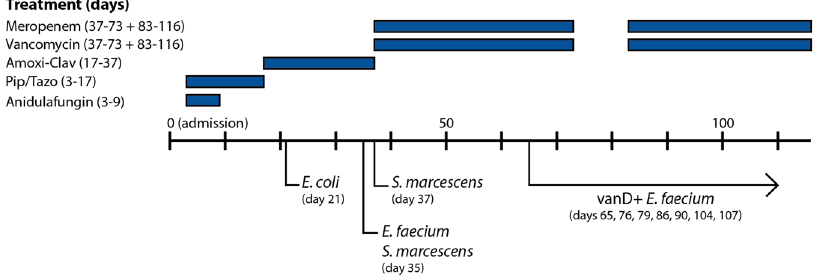
Figure 1. The time line of the patient, who initially presented with acute severe necrotizing pancreatitis on day 0 (admission). Over time, various microorganisms were isolated from clinical samples: E . coli on day 21 from fine needle aspirate (sensitive to all β -lactam antibiotics), Serratia marcescens (pip/tazo resistant) and Enterococcus faecium (amoxicillin resistant, vancomycin susceptible) on day 35 from transgastric drainage fluid. Serratia marcescens was also isolated from blood cultures on day 37. From day 65 on, a vancomycin resistant E . faecium was also isolated from rectal swabs. Earlier rectal swabs did not produce vancomycin resistant enterococci. Abbreviations: Amoxi-Clav (Amoxicillin-clavulanic acid), Pip/Tazo